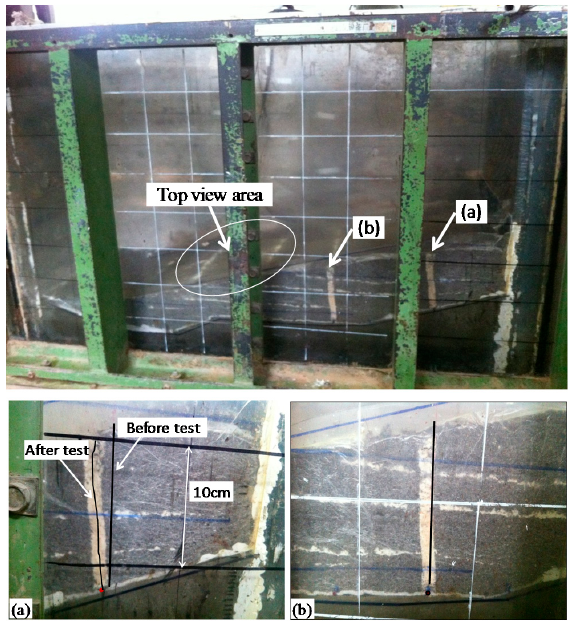
Figure 17. Photographs of failure mode (side view).